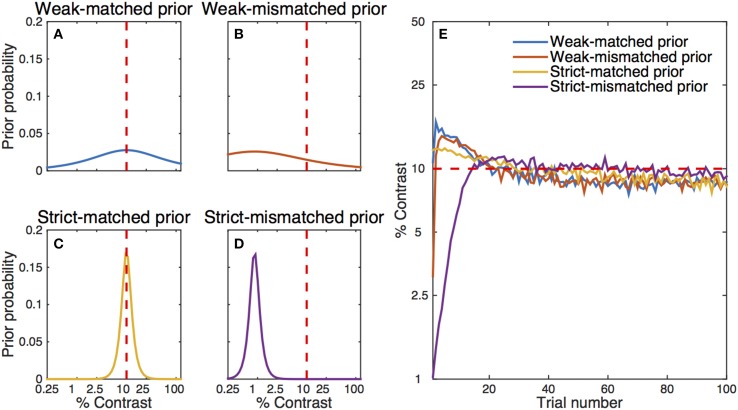
Simulation results with different initial prior distributions: (A) a weak- matched prior, (B) a weak-mismatched prior, (C) a strict-matched prior, and (D) a strict-mismatched prior. The red dashed line represents the simulated observer's true parameter. (E) Estimated contrast threshold as a function of trial number. The simulation results start with estimates after the simulation of the first trial, whereas the left panels represent prior distributions before the simulation of the first trial. The qYN/qFC methods gain much information in the first few trials, so that even a single (first) trial changes the posterior distribution. Note that there is some residual bias in the estimated contrast threshold even after 300 iterations of the procedure.